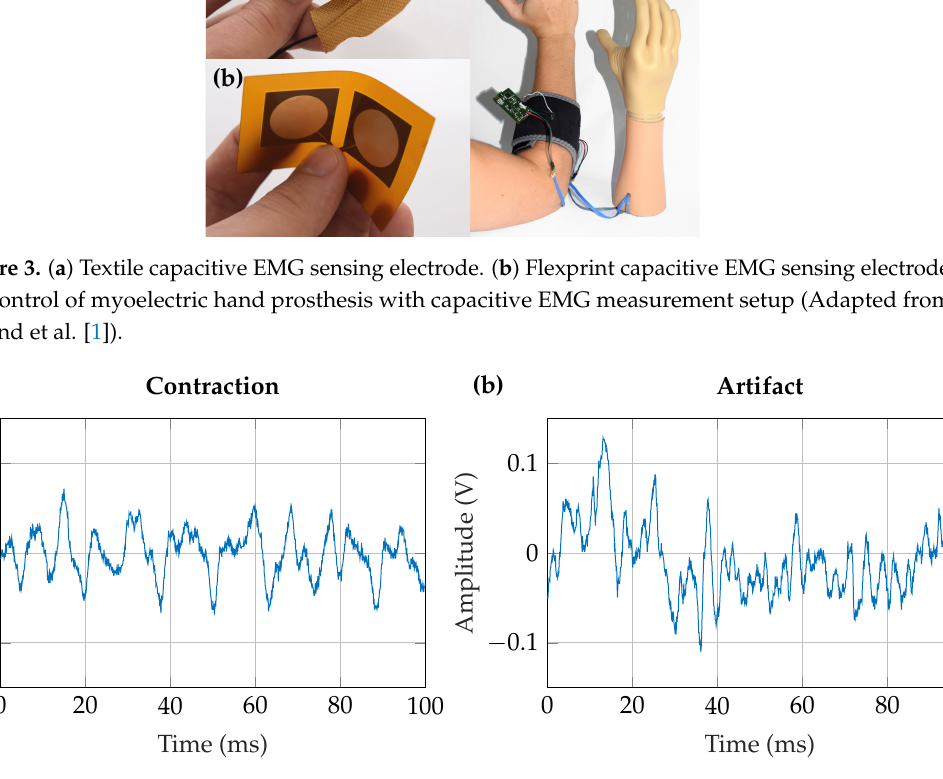
Figure 4. Raw signals measured with the capacitive EMG sensor at a sampling frequency of 10kHz. ( a ) EMG signal of a strong contraction. ( b ) Exemplary artifact. Please note that artifacts are varying greatly, depending on its